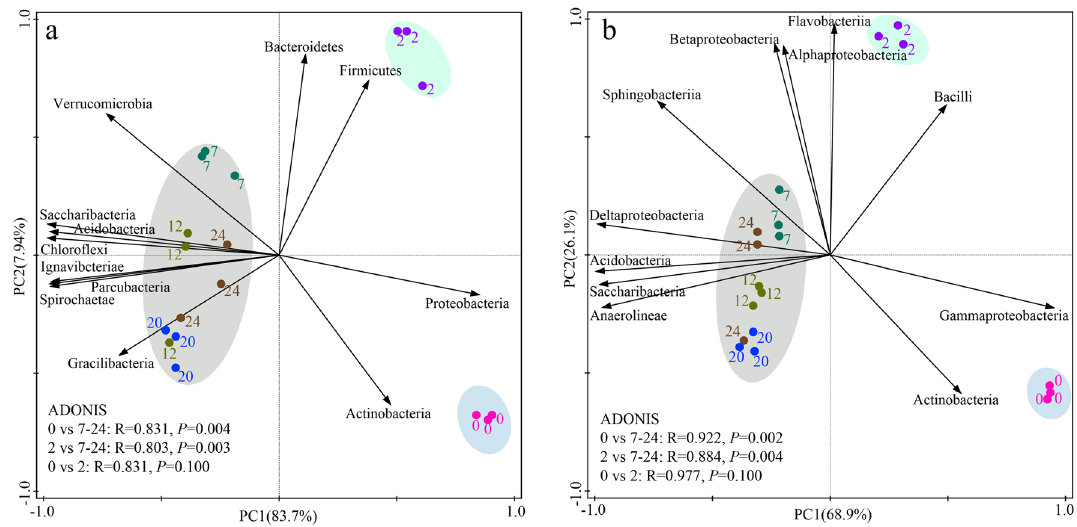
the PC1 axis from the positive axis to the negative axis, and the community composition at 7–24 months did not separate significantly. The bacterial community in the initial straw was dominated by Actinobacteria and Proteobacteria , and Bacteroidetes and Firmicutes dominated the community in the 2nd month. The leading roles of Acidobacteria , Chloroflexi , Ignavibacteriae , Gracilibacteria , Parcubacteria , Saccharibacteria , Spirochaetae , and Verrucomicrobia increased significantly during the 7–24 months. For bacteria at the genus level, the bacterial